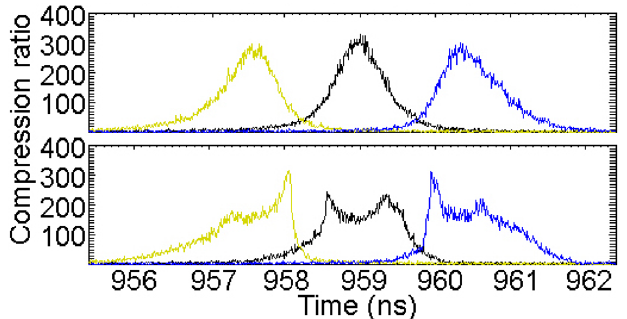
(cid:2) t (cid:3) =I comparison for the b 0